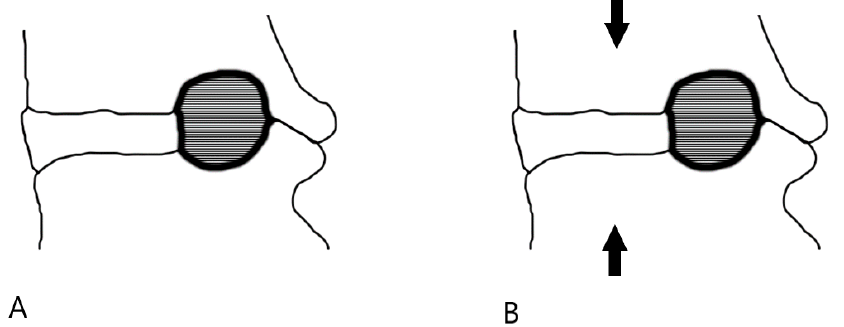
Figure 2. Image analysis. The sagittal cross-section area of the vertebral foramen without axial loading ( A ) and after axial loading ( B ).